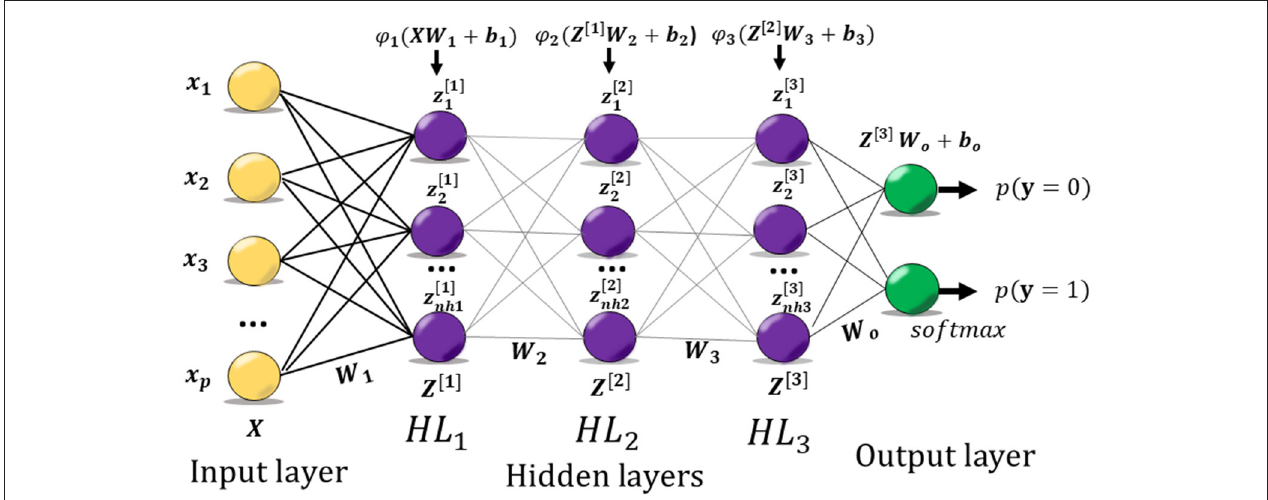
FIGURE 2 | Schematic representation of the trained multiple-layer perceptron neural networks. Each layer receives the outputs from the previous layer and computes weighted linear summations followed by some linear or nonlinear processing, X represents the audio-based features data, the W ’s and b ’s are the matrices or vectors of weights and biases, ϕ are the neurons activation functions, nh 1 , nh 2 and nh 3 are the number of neurons in the hidden